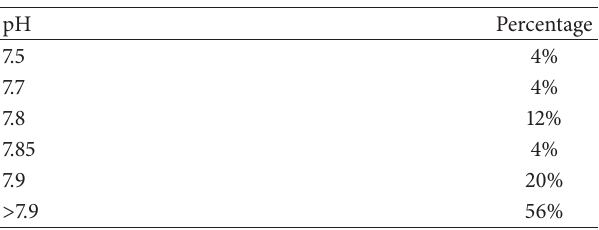
Table 2: p Η of cold shower (indirect samples).